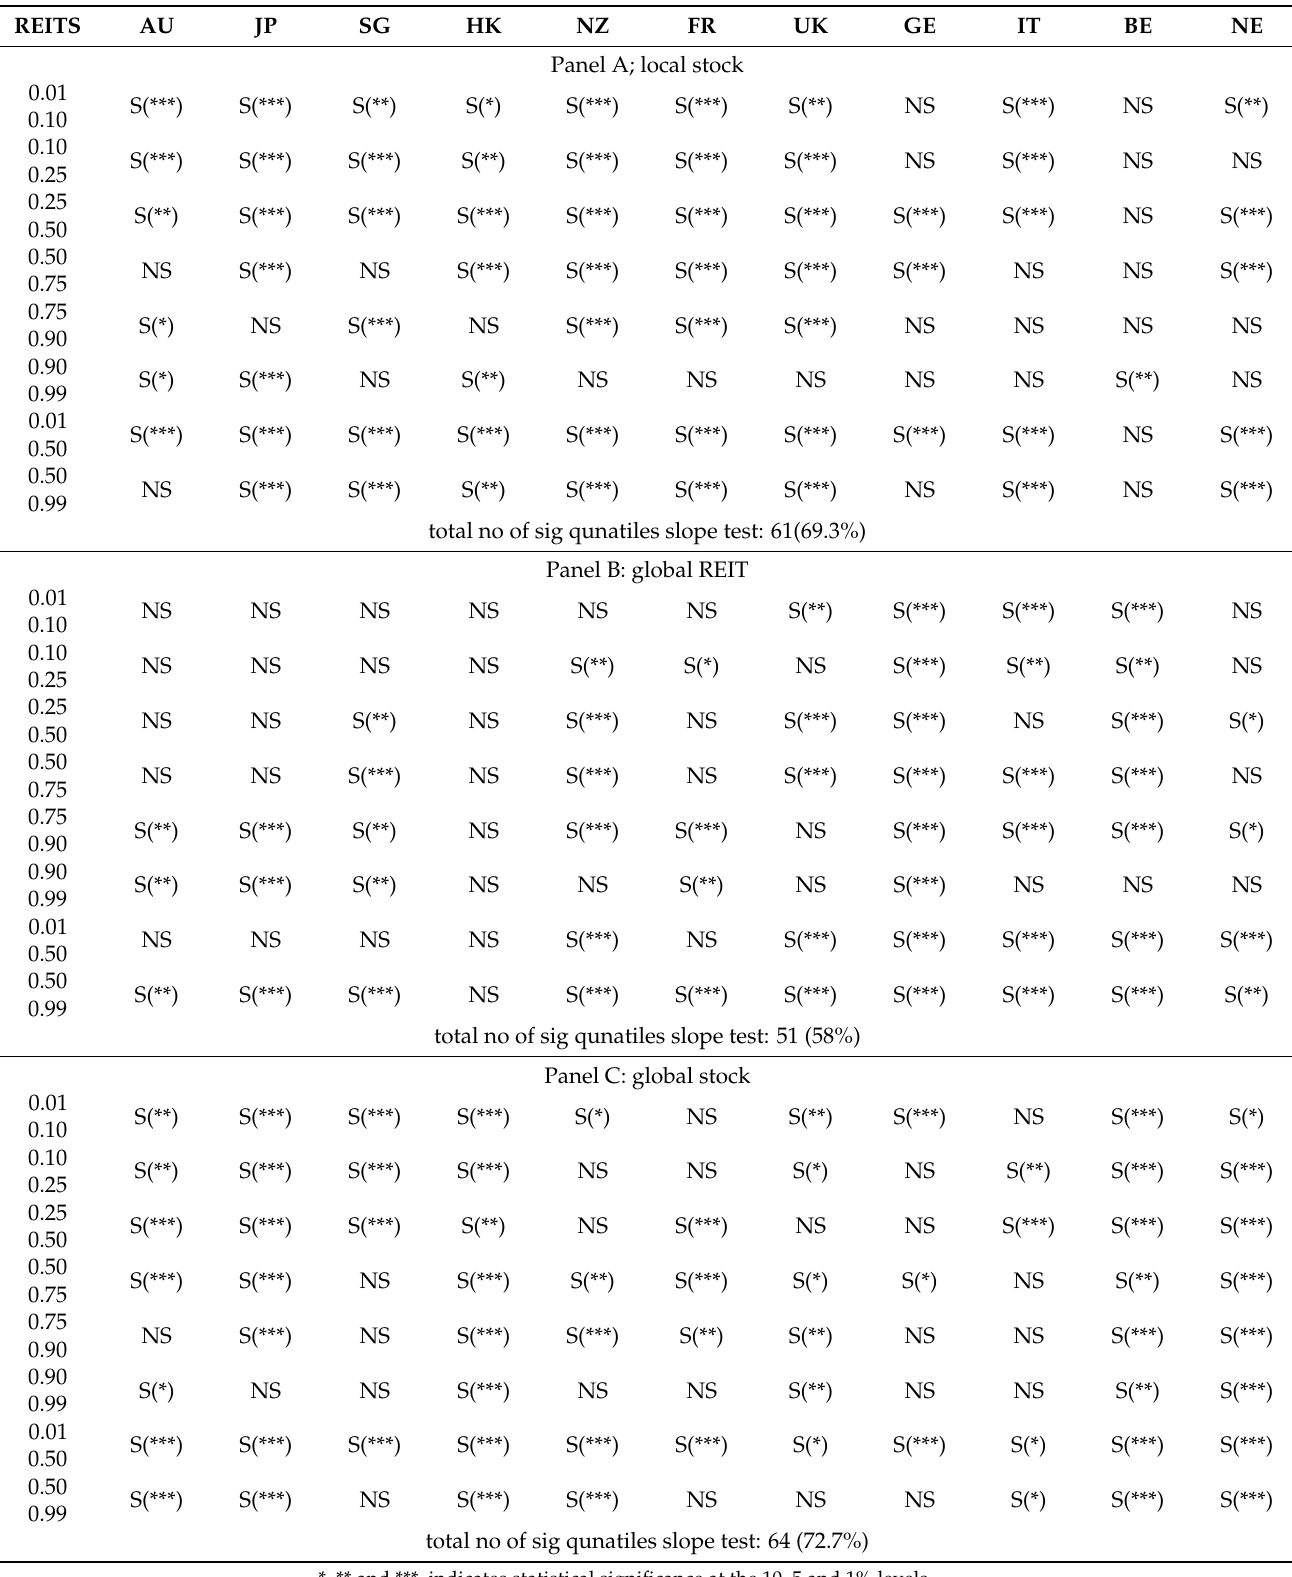
Table 3. Results of the quantile slope equality